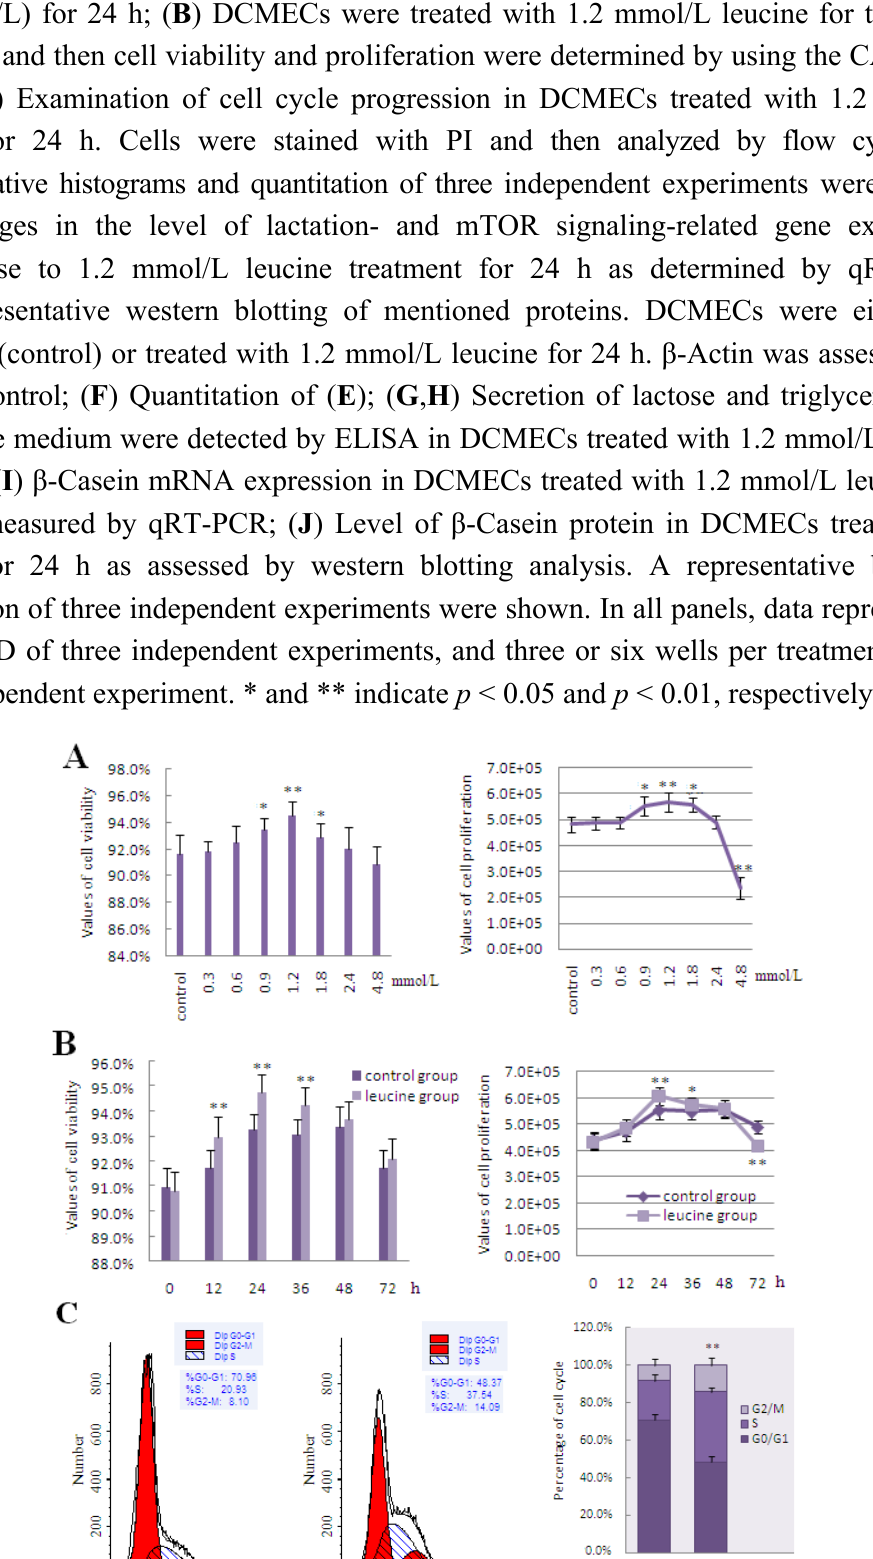
Figure 3. The effect of leucine on LeuRS to regulate cell growth and expression of proteins involved in mTOR signaling in DCMECs. ( A ) DCMECs were left untreated (control) or treated with varying concentrations of leucine (0.3, 0.6, 0.9, 1.2, 1.8, 2.4, and 4.8 mmol/L) for 24 h; ( B ) DCMECs were treated with 1.2 mmol/L leucine for the